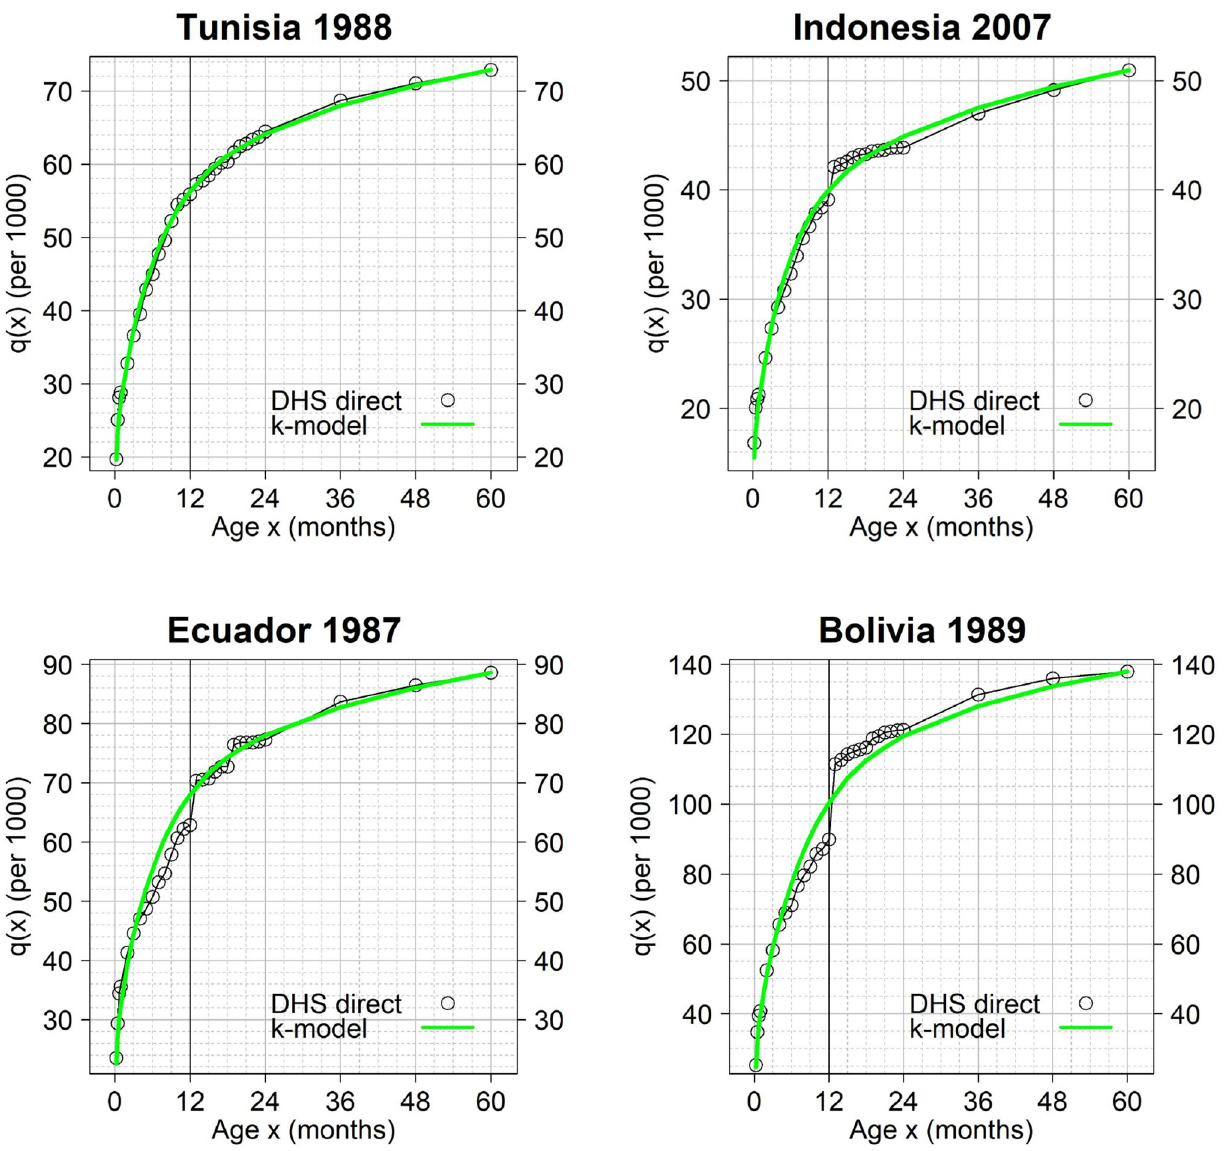
Fig 6. Examples of surveys with very good fit of the k-model. Prediction errors are within the 90% maximum values. The k-model was fitted to the observed q ( x ) values using ages 0–8 and 24–60 months only. The ticker vertical line indicates the comparison between the observed and predicted infant mortality rate